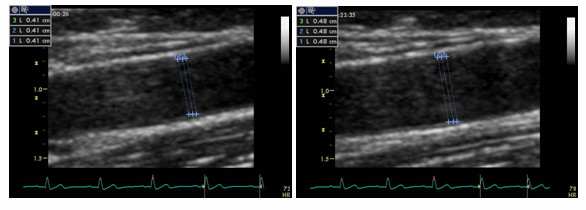
Two-dimensional images of the brachial artery in a case with preserved endothelium dependent flow mediated dilation. Brachial artery measurements were made from anterior intima to posterior intima at baseline, and during reactive hyperaemia. Endothelium dependent vasodilation response was 17.1%.